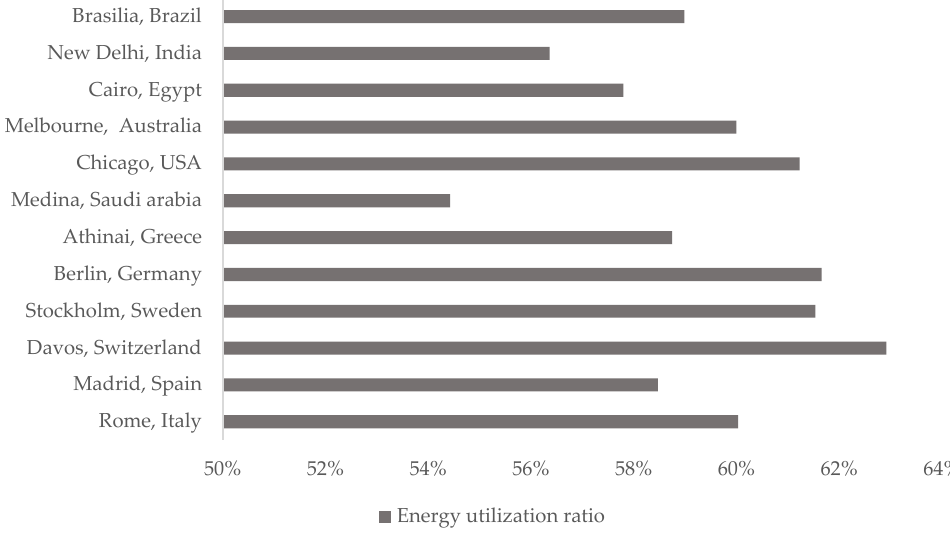
Figure 14. Collector energy utilization ratio.